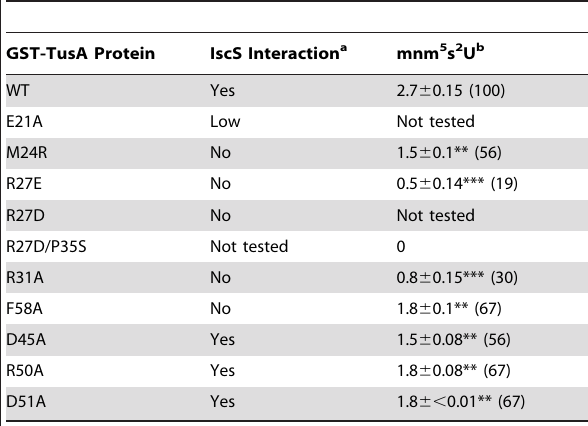
Table 4. Properties of TusA mutant proteins as assessed from pull-down and in vivo complementation